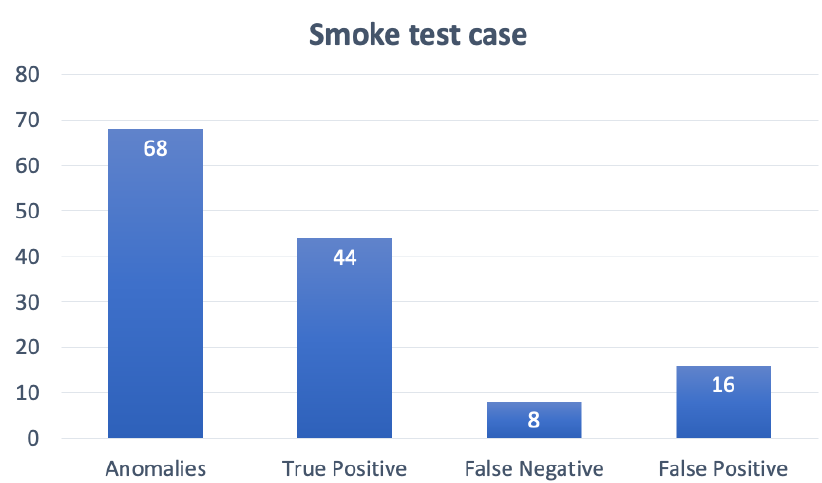
Figure 7. Anomalies related to the smoke test case, as detected by the system.